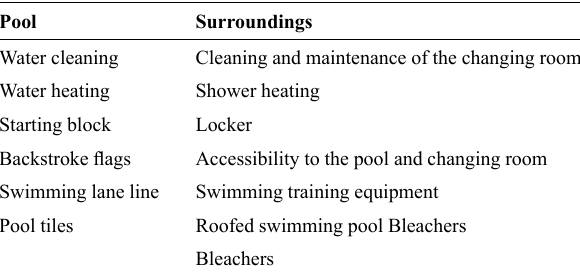
Table 1 - Analysis factors to identify the physical conditions of pools and their surroundings. Source: own elaboration.